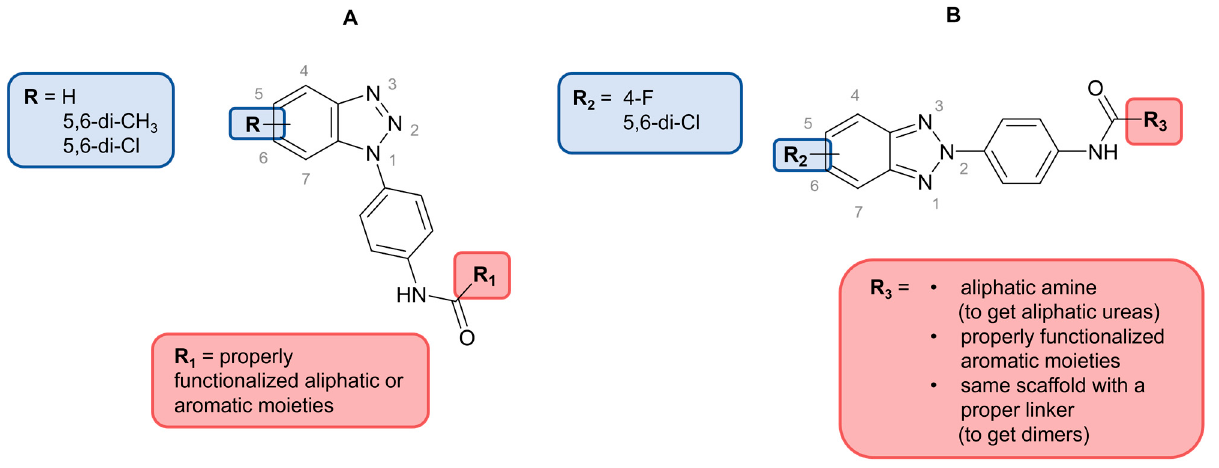
Figure 2. General structures of our benzotriazole-based antiviral compounds: series ( A ), active against CVB (EC 50 values between 8–10 µ M) and RSV (EC 50 values 3–7 µ M). Series ( B ), active on HTNV (EC 50 < 5 µ M), CVB (EC 50 values between 4–8 µ M) and RSV (EC 50 values 2–3 µ M) [51–54].